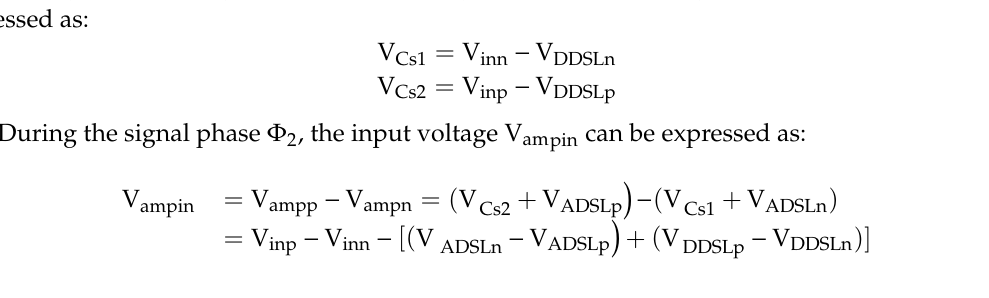
Figure 3. Circuit implementation of the sampling input stage.